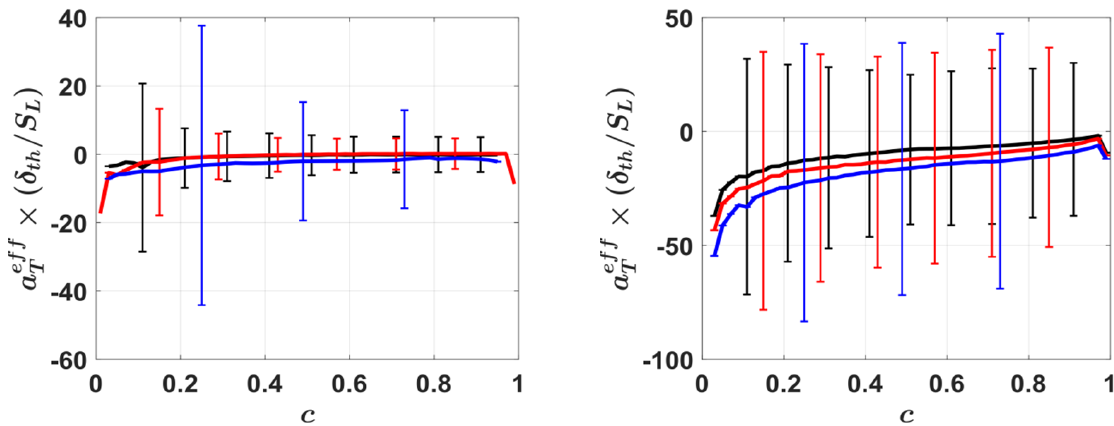
Figure 15. Profiles of the normalised mean values and standard deviations of the effective tangential strain rate ( (cid:1853) (cid:3021)(cid:3032)(cid:3033)(cid:3033) × (cid:2012) (cid:3047)(cid:3035) / (cid:1845) (cid:3013) ) conditioned upon (cid:1855) for (cid:1873) (cid:4593) (cid:1845) (cid:3013) ⁄ = 4.0 (black) 6.0 (red) and 8.0 (blue) for statistically planar turbulent premixed flames (first column) and homogeneous MILD combustion cases (second column). Note the difference in scales between the premixed flame and MILD combustion cases.